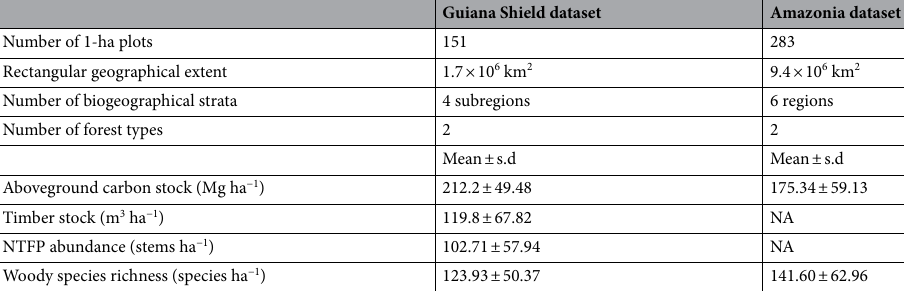
Table 3. Overview of the two datasets used in this study, showing sample size, geographical extent and the number of biogeographical strata and forest types included. Biogeographical strata and forest types were recognized after Stropp 30 , ter Steege et al . 32,45 and ter Steege & Zondervan 46 . In addition, for each of the three ecosystem service stock components and woody species richness showing their mean value and standard deviation (mean ± s.d.). See Table S1.3 for a summary of the plot data, including references. NTFP abundance = abundance of species that produce non-timber forest